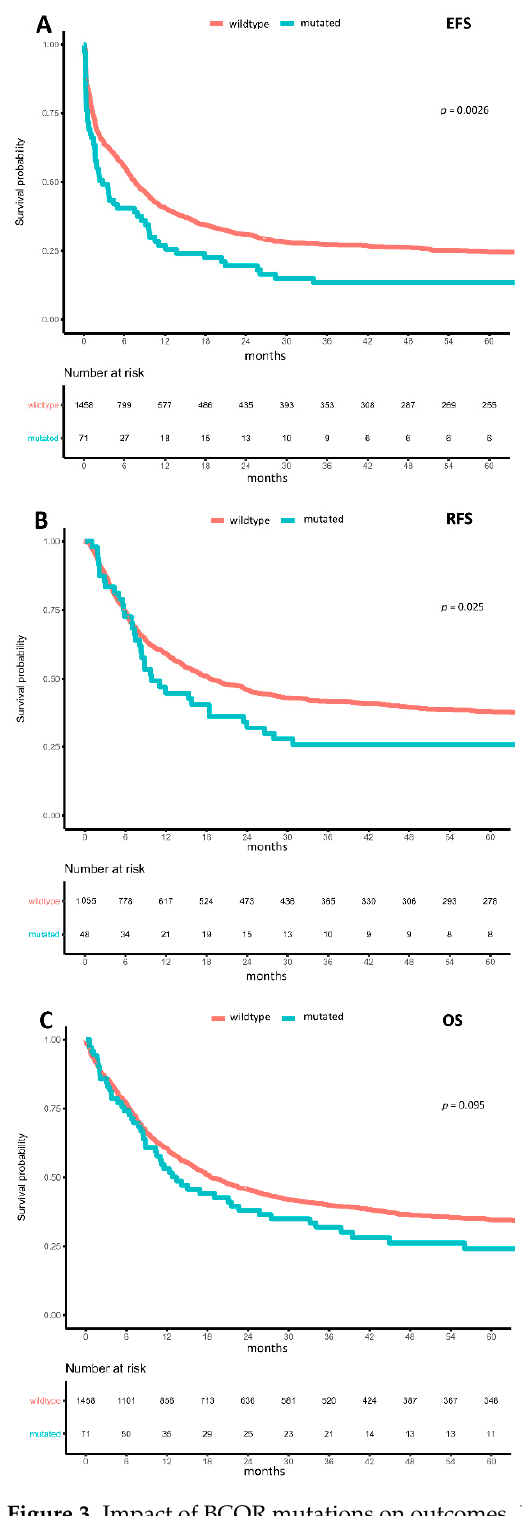
Figure 3. Impact of BCOR mutations on outcomes. Kaplan–Meier plots for ( A ) event-free survival, ( B ) relapse-free survival, and ( C ) overall survival in AML, with wild-type (orange) and mutated (turquoise) BCOR compared using the logrank test.